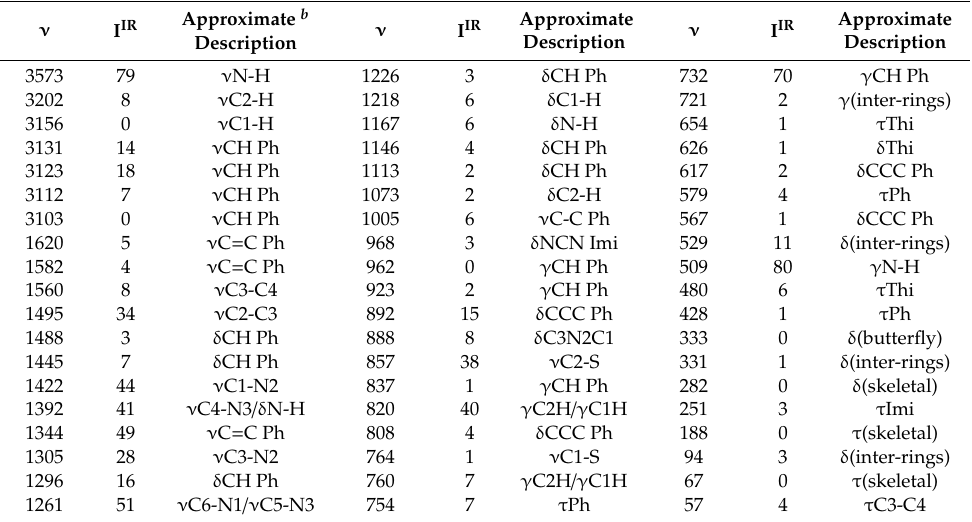
Figure 5. Calculated infrared spectrum of thiabendazole (isolated molecule; trans conformer; wavenumbers scaled by 0.978). Table 2. B3LYP / 6-311 ++ G(2d,2p) calculated infrared spectra for thiabendazole (conformer trans ; isolated molecule) a .